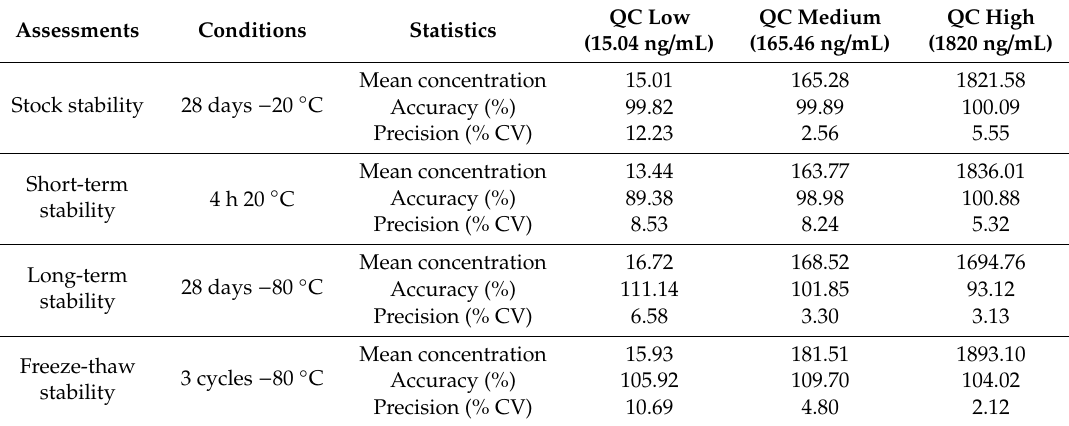
Table 2. The stability assessments of SCH 58261 in rat plasma ( n =